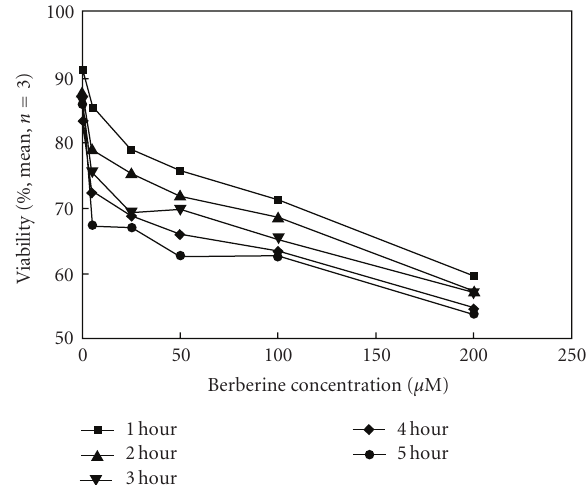
Figure 13: Viability of nasopharyngeal carinoma cells (NCP/HK1) after berberine treatment. Cells were incubated in di ff erent concen- trations (5 to 200 μ M) of berberine for 1 to 5 hours). Reprinted from Szeto et al. [115] with permission from Turkish Journal Medical Science with permission from the publishers.